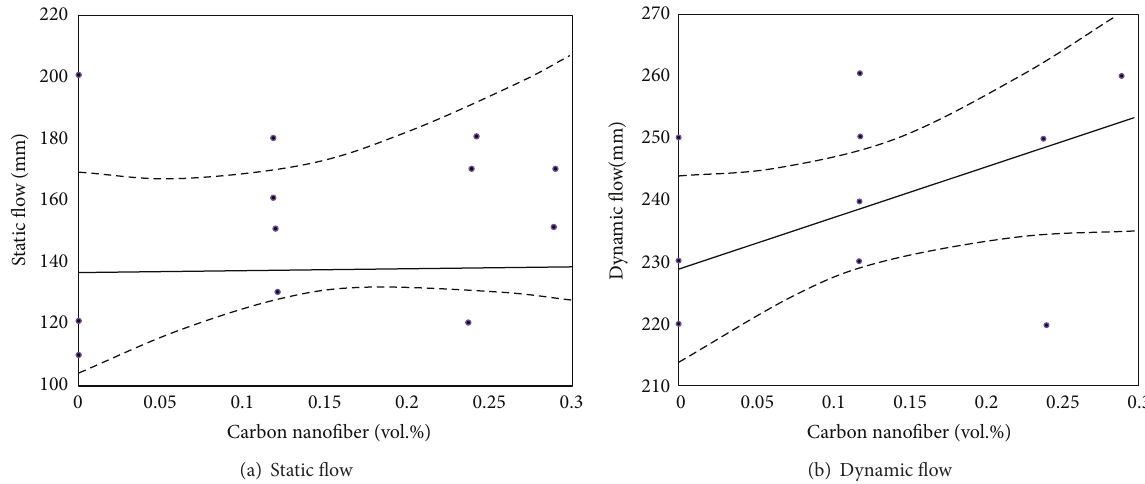
Figure 6: Effects of carbon nanofiber volume fraction (with respect to anhydrous cementitious materials) on the static and dynamic flow of fresh mix (regression lines and 95% confidence intervals are shown; steel fiber volume fraction